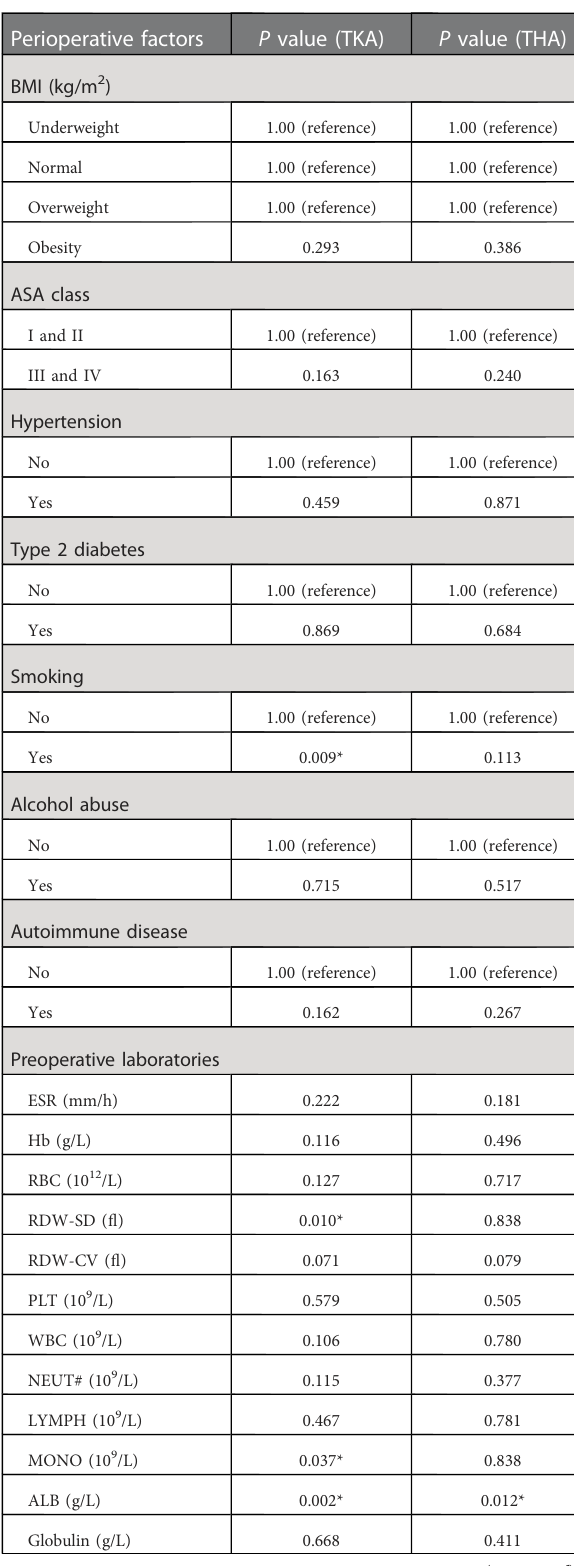
TABLE 3 Univariable analysis of risk factors for acute postoperative infection after TKA and THA. Perioperative